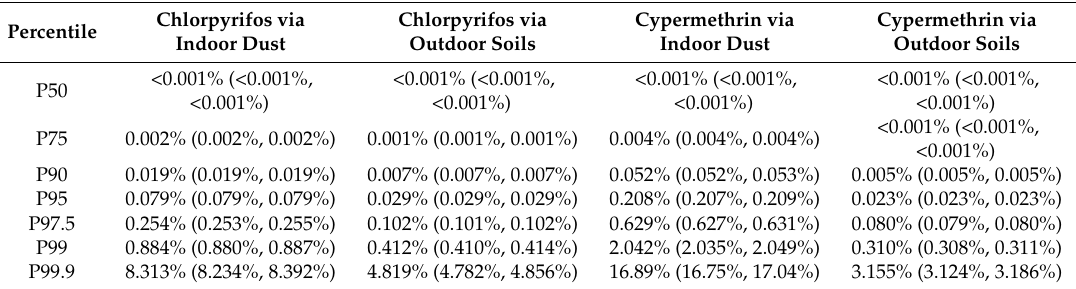
Table 2. Non-dietary ingestion exposures in terms of percentage of Acceptable Daily Intake for young